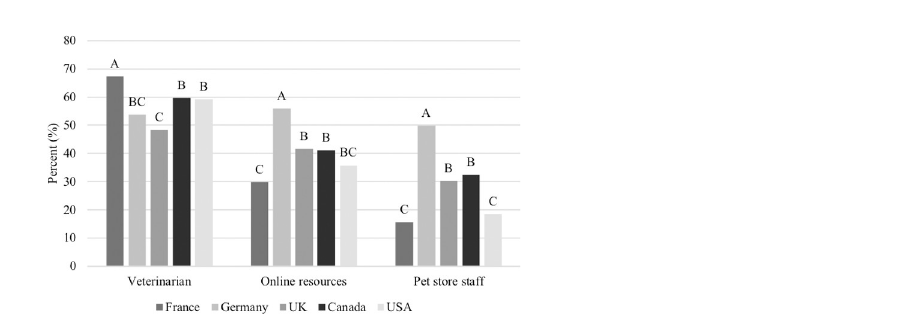
Fig 5. Percent of respondents that get their information about pet food from a veterinarian, online and/or from pet store staff among countries (n = 3,298). Proportions in the same category that do not share a common letter are significantly different at P < 0.05.